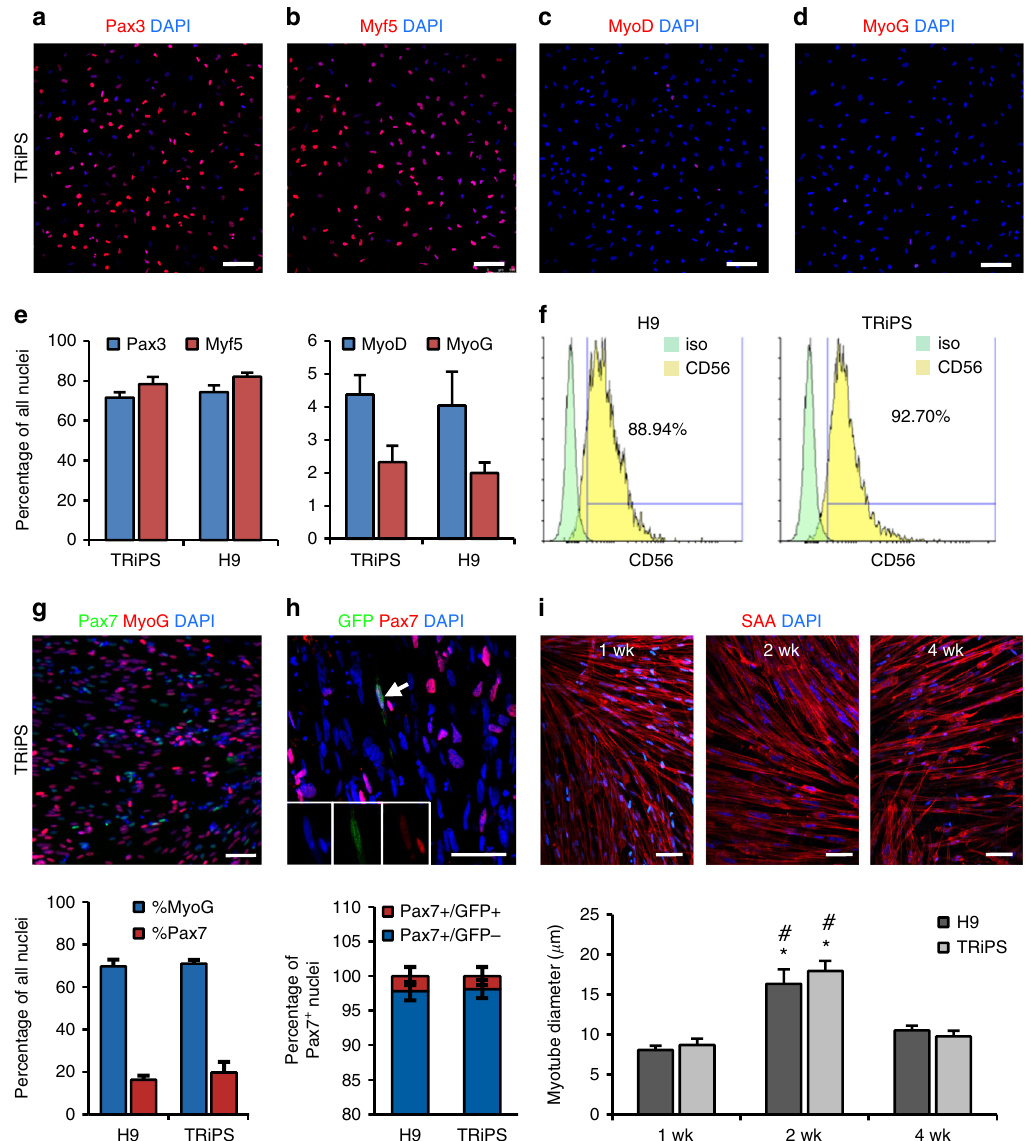
Fig. 2 Characterization of iMPCs during monolayer differentiation. a – e Representative immunostaining of Pax3 ( a ), Myf5 ( b ), MyoD ( c ), and MyoG ( d ), and corresponding quanti fi cation ( e ) during iMPC expansion. Scale bar = 100 µ m. f Representative FACS analysis for CD56 in H9 and TRiPSC derived iMPCs. g Representative immunostaining (top) and quanti fi cation (bottom) of Pax7 + and MyoG + cell populations for H9 and TRiPS derived myotubes at 2 weeks of monolayer differentiation. ( n = 6 samples from 2 differentiations for each cell line). h Representative immunostaining and quanti fi cation of GFP + /Pax7 + and GFP - /Pax7 + cell pools at 2 weeks of monolayer differentiation. Scale bar = 50 µ m. ( n = 4 samples from 2 differentiations for each cell line). i Representative immunostaining and quanti fi cation of myotube diameter at 1, 2, and 4 weeks of monolayer differentiation. (* P < 0.05 vs. 1 week, # P < 0.05 vs. 4 week, Tukey – Kramer HSD test; n = 6 samples from 2 differentiations for each cell line). Scale bars = 50 µ m. Data are presented as mean ±